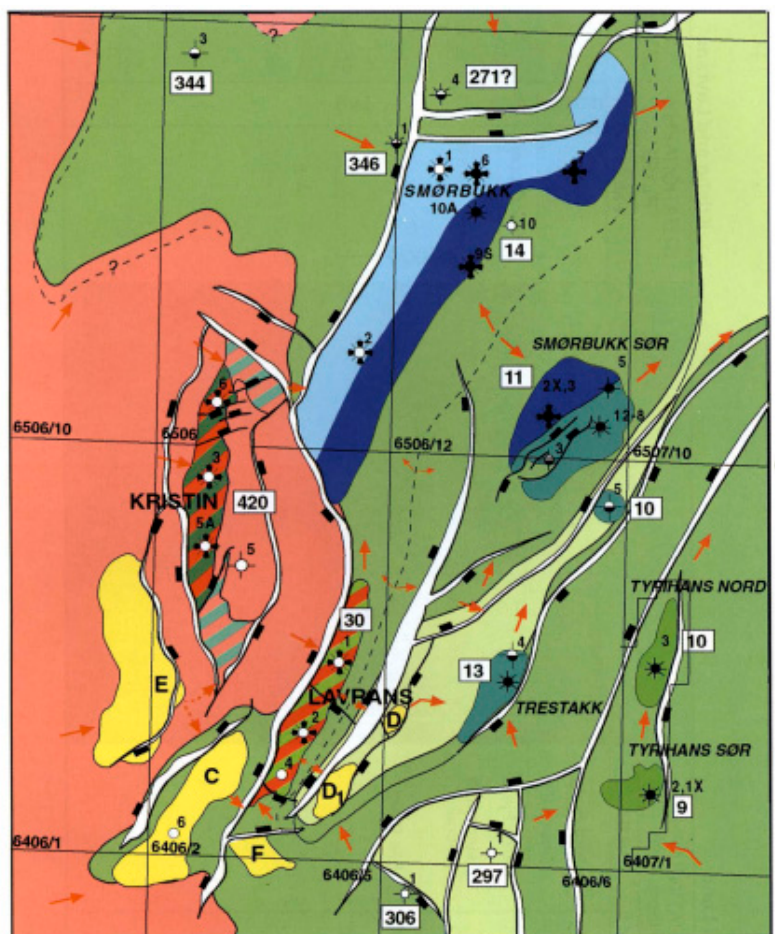
Figure 4. Geometry and position of the Kristin field. Reproduced with permission from [144].